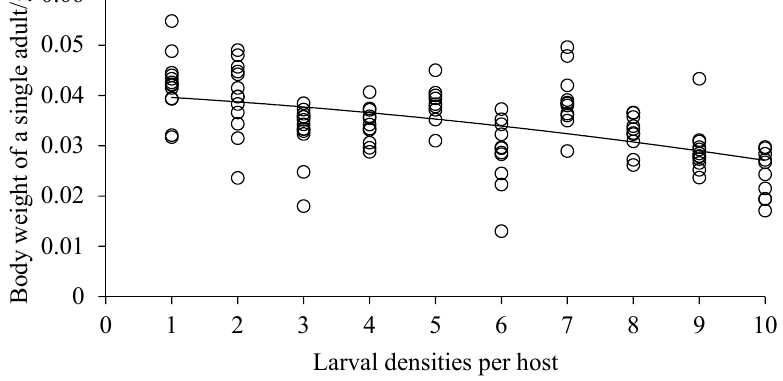
Figure 4. Bodyweight of a single D. helophoroides adult with various larval densities. Relationship between larval densities per host and bodyweight of a single D. helophoroides adult ( y = − 0.00006 x 2 − 0.0007 x + 0.0404; adjusted r ² = 0.5594, p < 0.01).